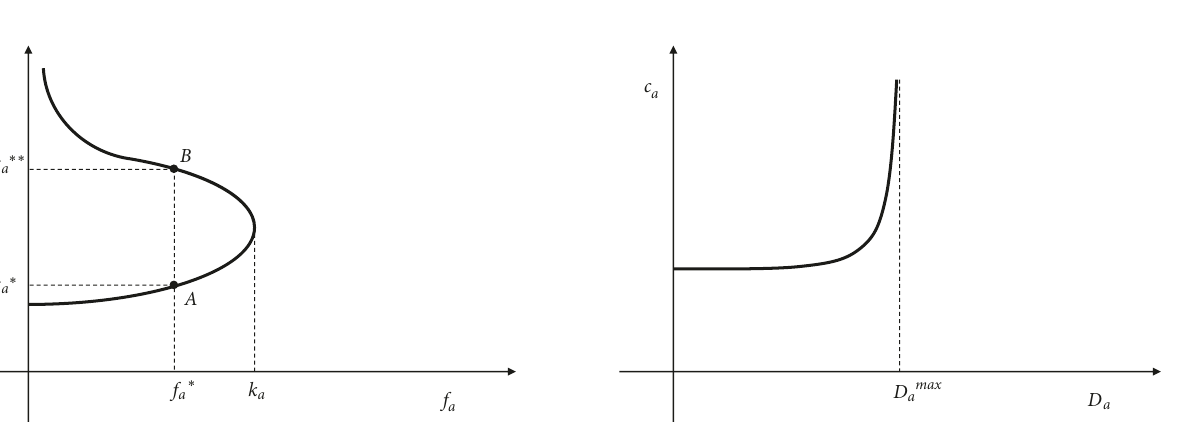
Figure 1: Relatively realistic flow-delay relationship on road link.